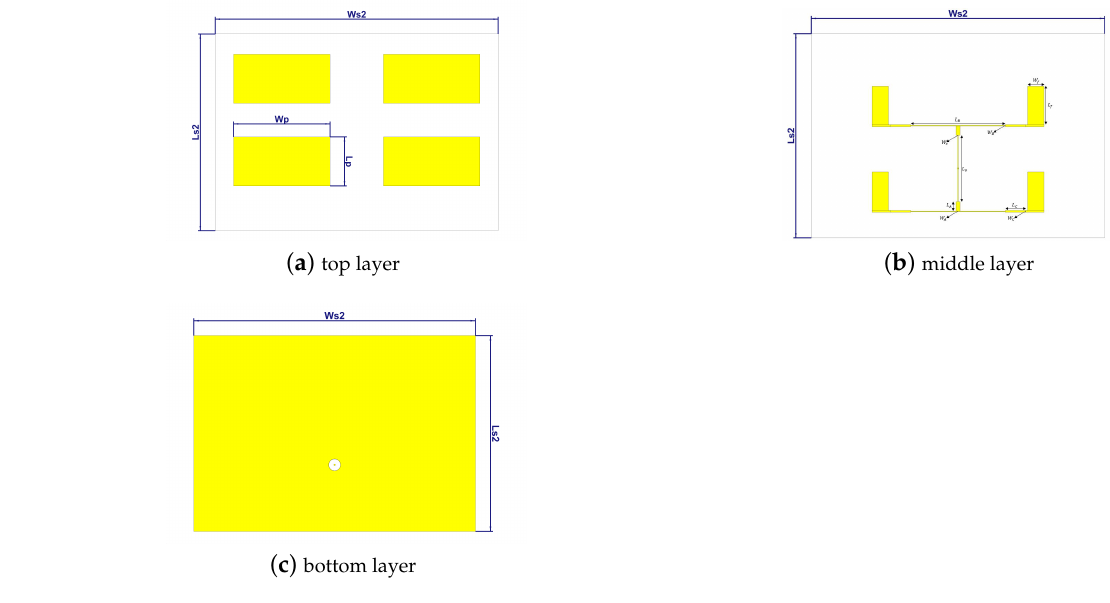
Figure 1. The 2 × 2 microstrip array antenna